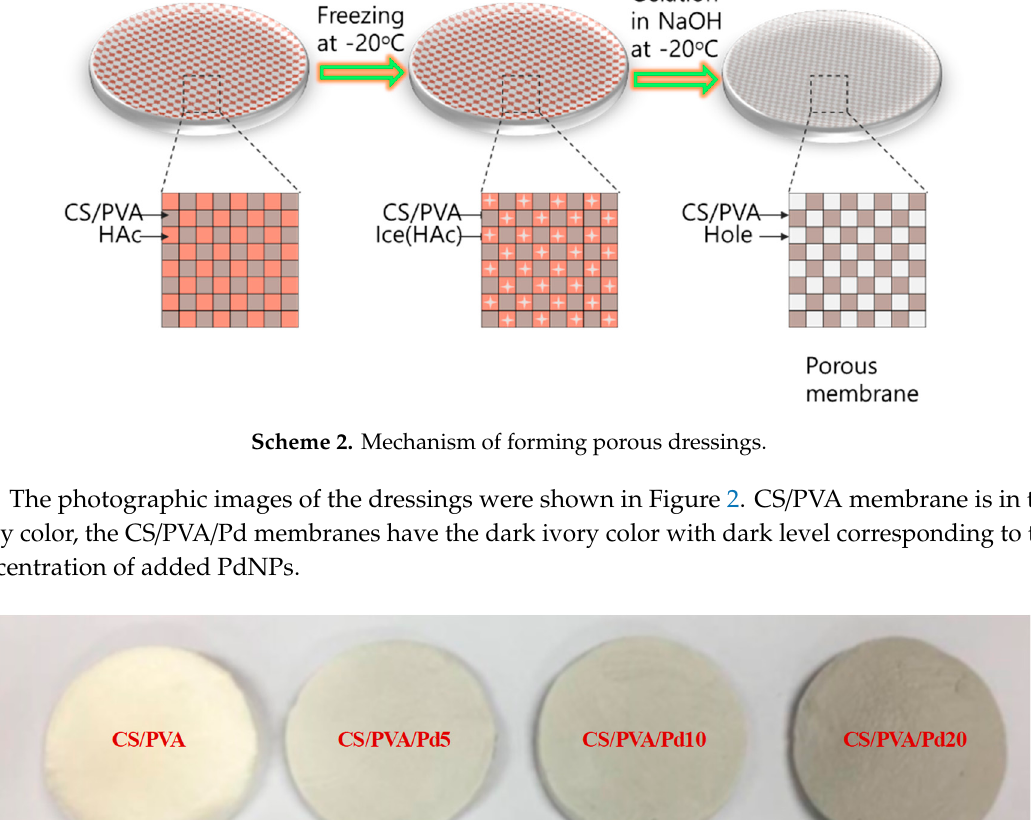
Figure 2. Photograph images of dressings.